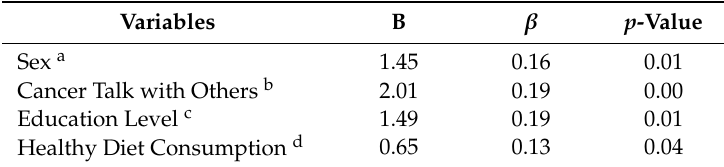
Table 2. Multiple linear regression to identify the predictors of awareness on students.